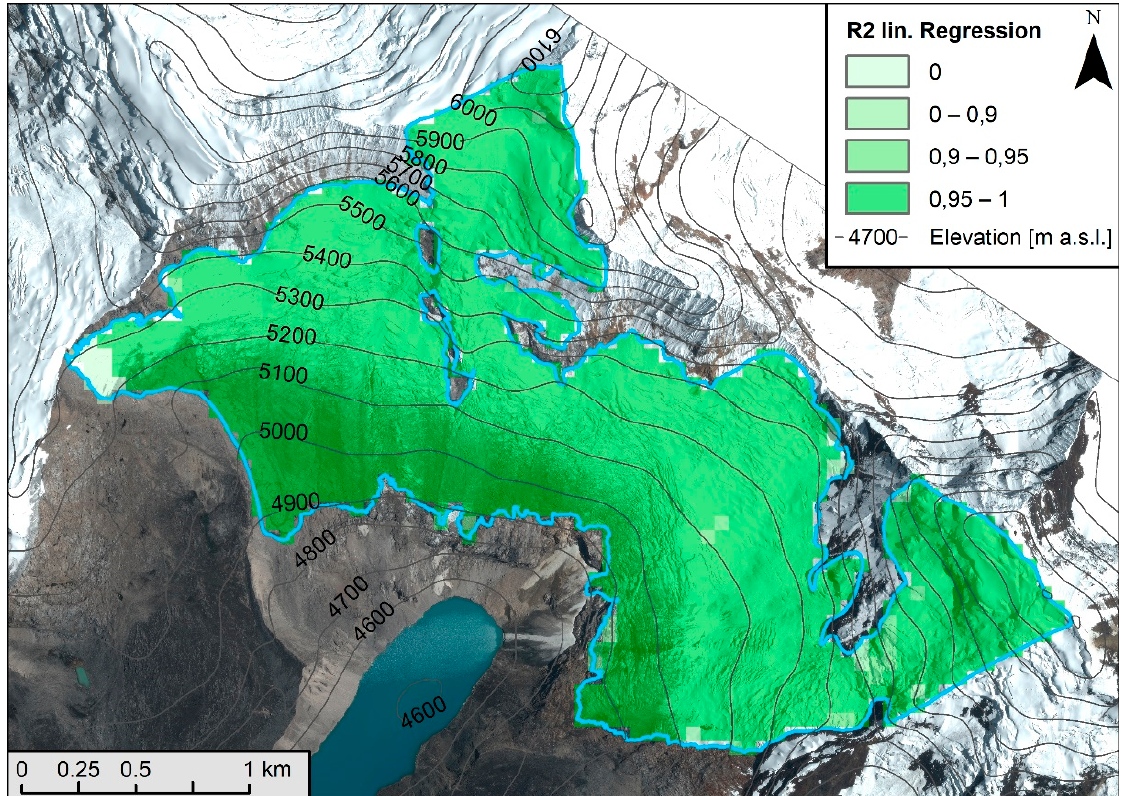
Figure 4. Spatial distribution of coefficient of determination (R 2 ) from the linear correlation analysis.